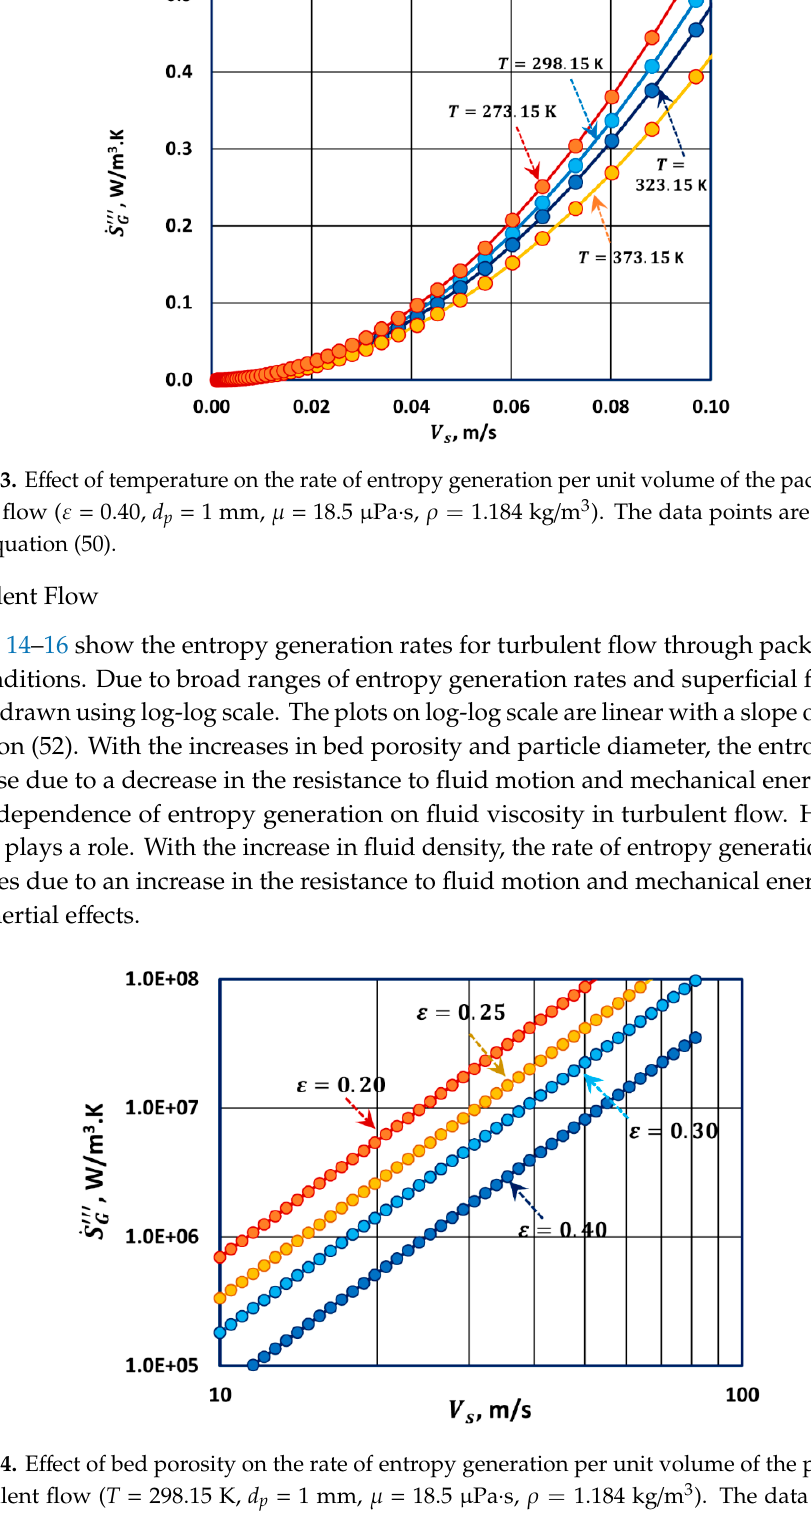
16 of 22 Figure 12. Effect of particle diameter on the rate of entropy generation per unit volume of the packed bed in laminar flow ( (cid:1846) = 298.15 K, (cid:2013) = 0.40, (cid:2020) = 18.5 µPa·s, (cid:2025) = 1.184 kg/m 3 ). The data points are generated using Equation (50). Figure 13 shows the effect of temperature on the rate of entropy generation in laminar flow through packed beds. The rate of entropy generation decreases with the increase in temperature keeping other factors (fluid properties, bed characteristics) constant. At a given fluid velocity (cid:1848) (cid:3046) , the rate of mechanical energy dissipation into internal energy is the same at different temperatures as the fluid properties are kept constant. Then why does the rate of entropy generation decrease with the increase in temperature? It so happens that the increase in entropy with the increase in internal